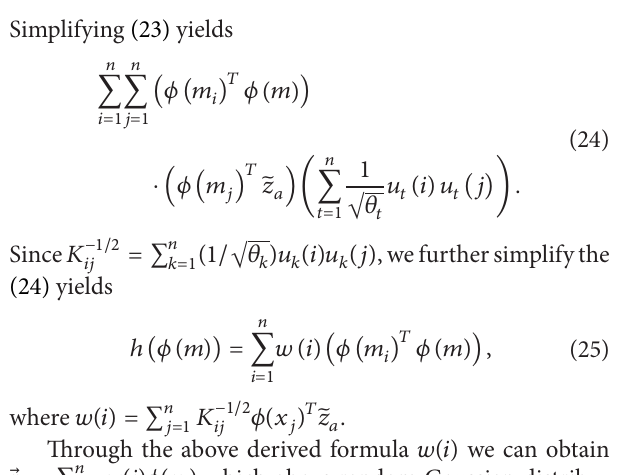
Figure 1: Datasets: Caltech-101